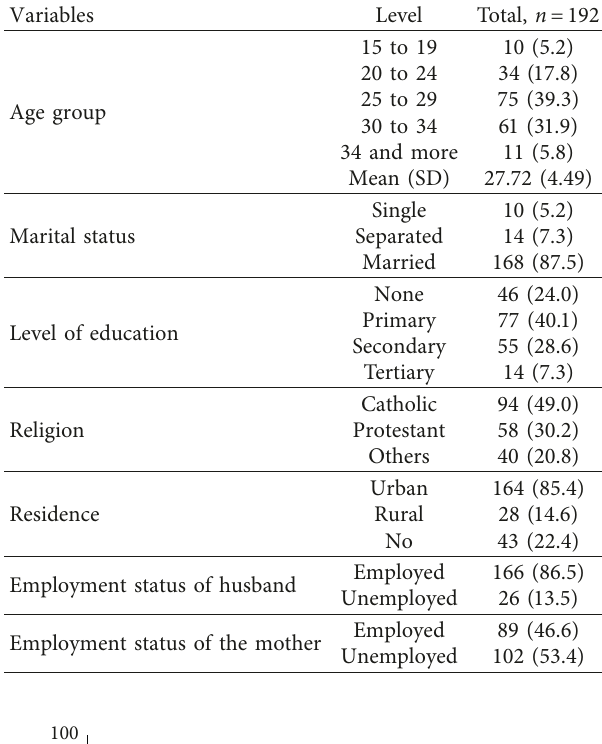
Table 1: Socio-demographic characteristics of participants.